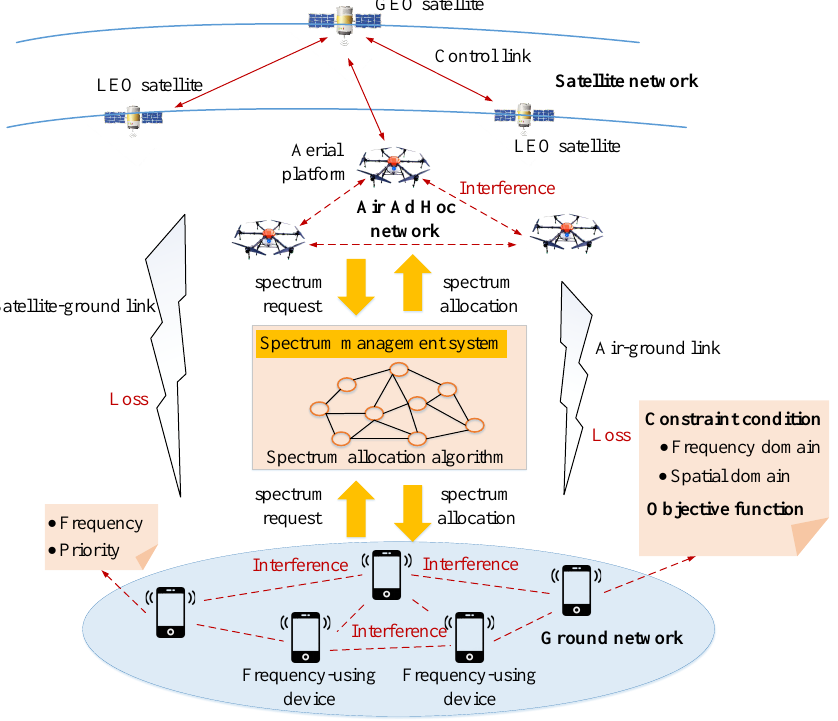
Figure 1. Spectrum allocation system model in space–air–ground integrated